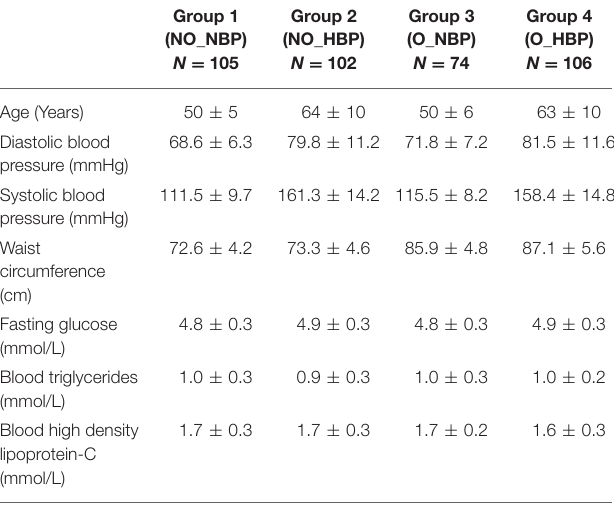
TABLE 1 | Baseline characteristics of age and metabolic risk factors in the following 4 groups: (1) Non-central obese subjects with normal blood pressure (NO_NBP; n = 105), (2) Non-central obese subjects with hypertension (NO_HBP; n = 102), (3) Central obese subjects with normal blood pressure (O_NBP; n = 74), and (4) Central obese subjects with hypertension (O_HBP; n =